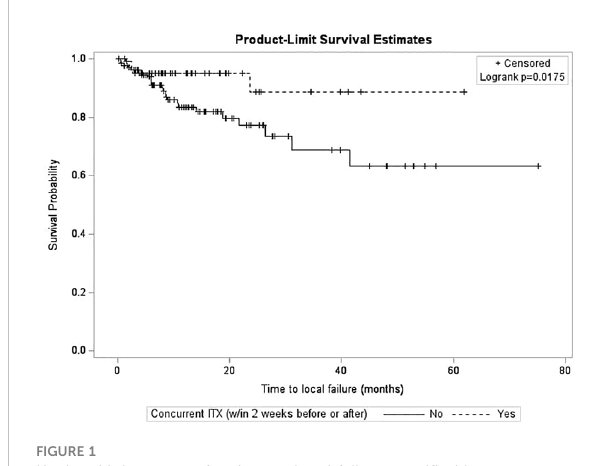
FIGURE 1 Kaplan-Meier curves for time to local failure strati fi ed by immunotherapy.